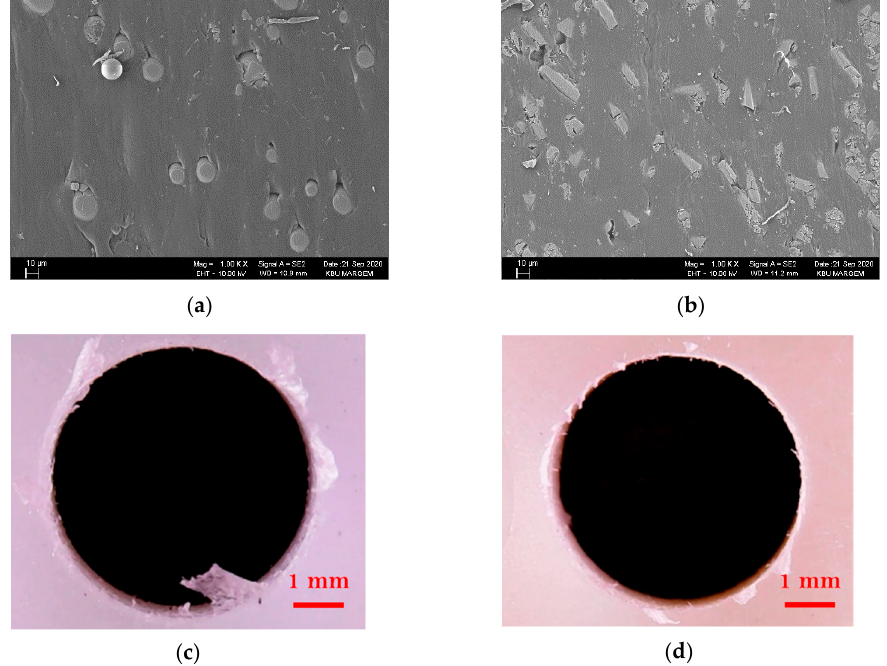
Figure 8. V = 45 m/min, f = 0.05 mm/rev: ( a ) C1 and ( b ) C2 hole surface SEM images, ( c ) C1 and ( d ) C2 hole exit images.